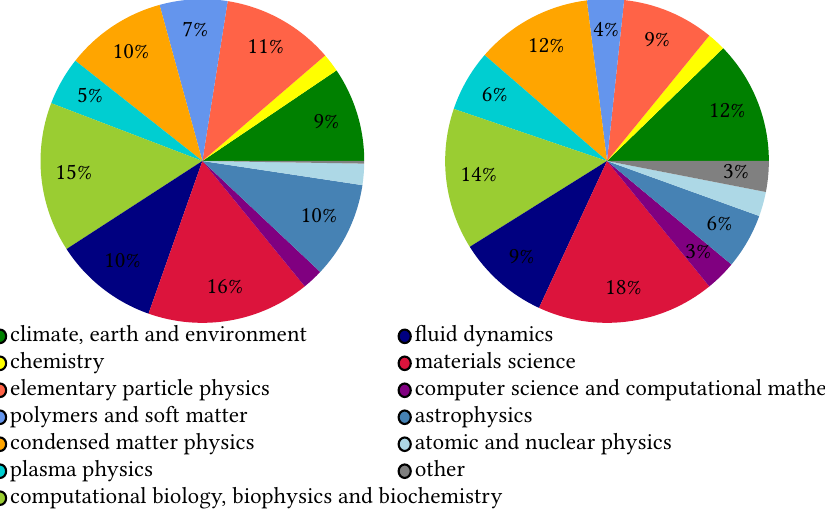
Figure 4: Allocated compute time (left) and number of projects (right) on JURECA by scientific field in the computing time period from the 1st of November 2015 to the 30th April 2016. Percentages are shown for shares above 3